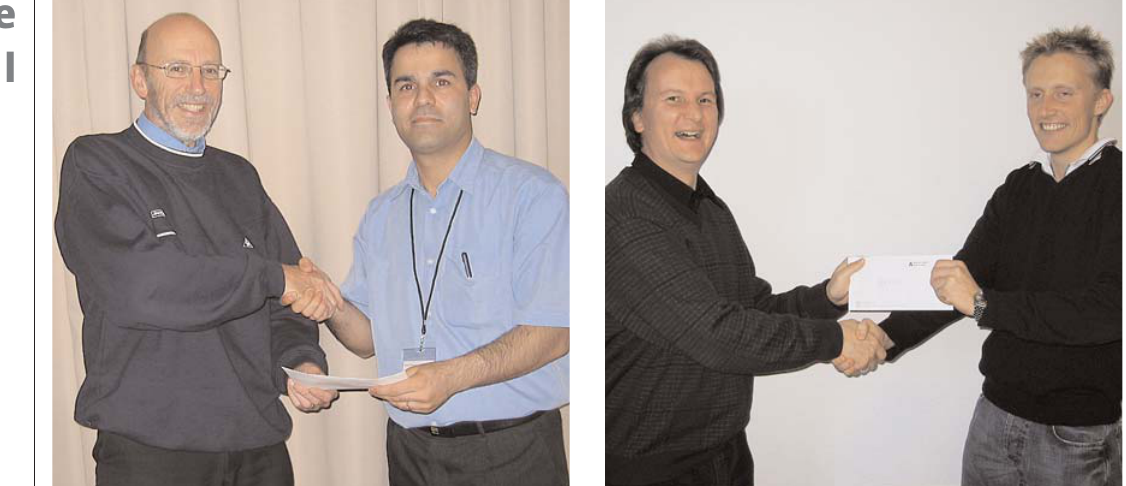
Figure 4 (left): Prof. Phil Banfill presents Hamid Sariff with the NRS award for best presentation. Figure 5 (right): Niall Young presents the NRS Young Rheologists award to Anders